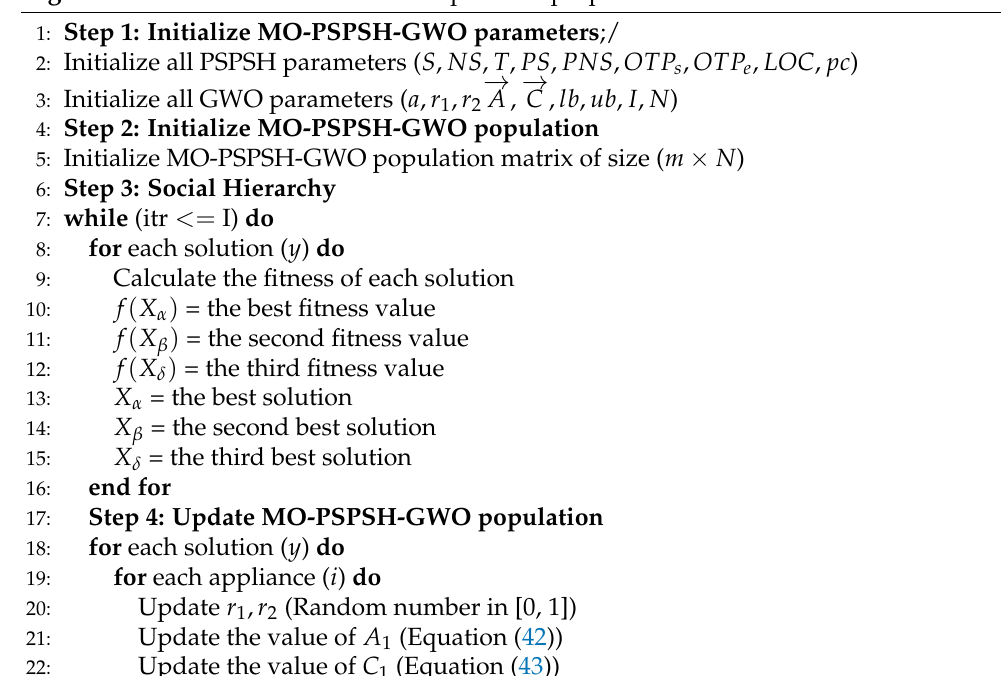
Algorithm 6 Pseudocode of the five steps of the proposed